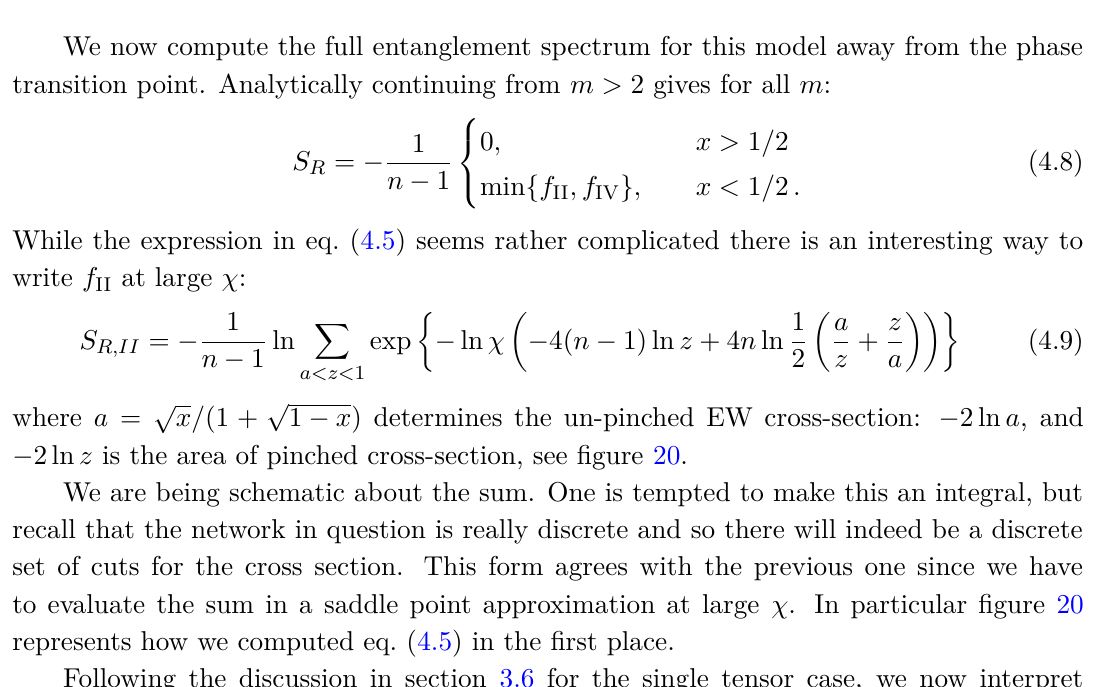
Figure 20 . The bulk setup used to calculate eq. (4.9). We work within Poincaré hyperbolic coordinate with moving downward as going deeper into the bulk. The position of various end points are shown in terms of a and z